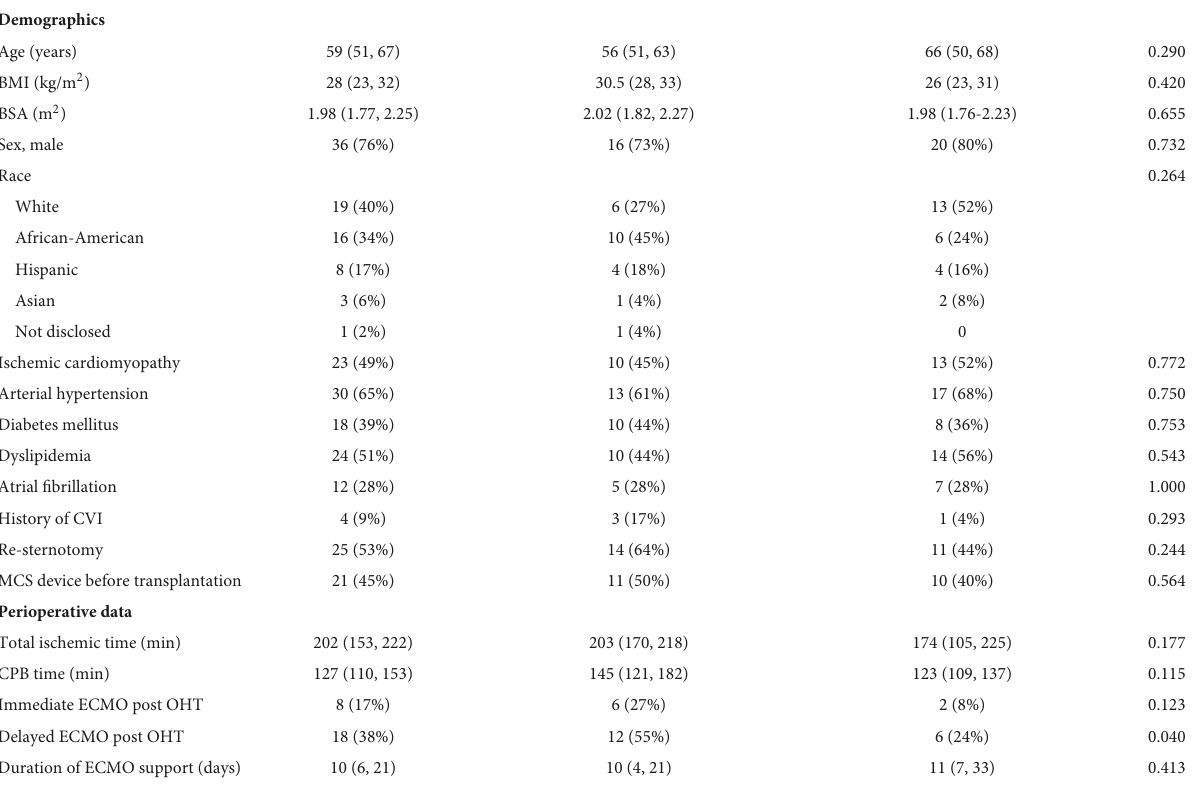
TABLE 1 Baseline demographics and perioperative data.